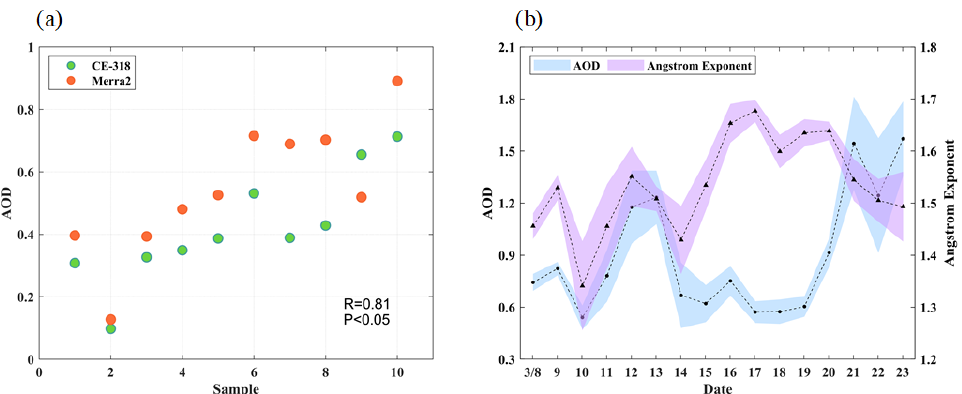
Figure 10. ( a ) Scatter plot of AOD from MERRA-2 and sun photometer. ( b ) Daily variations of AOD and Angstrom Exponent from 8 to 23 March 2021.